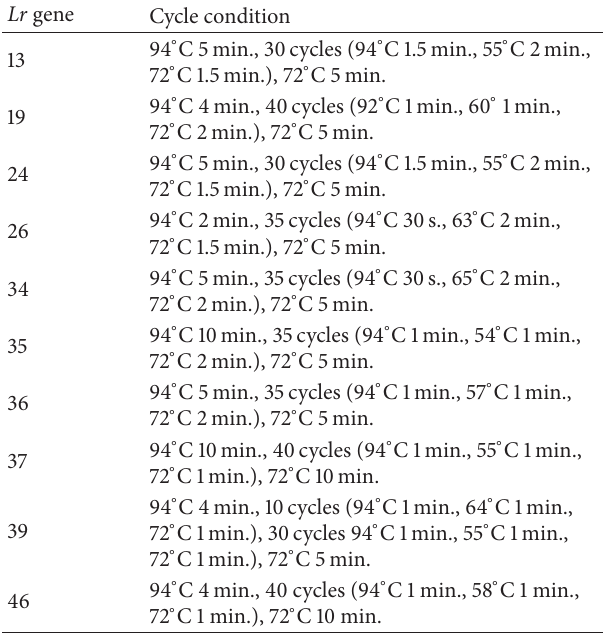
Table 2: Amplification parameters for all primer sets used. Lr